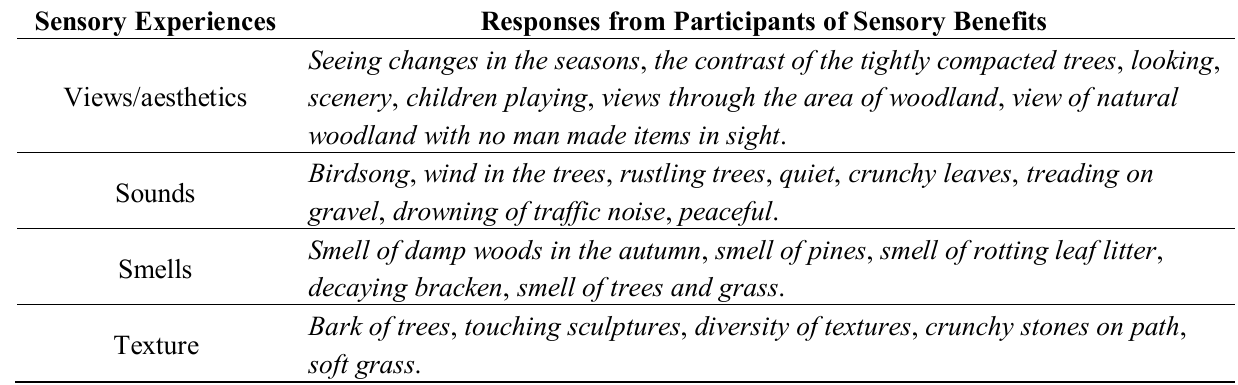
Table 3. Participants‘ examples of sensory aspects of woodlands they